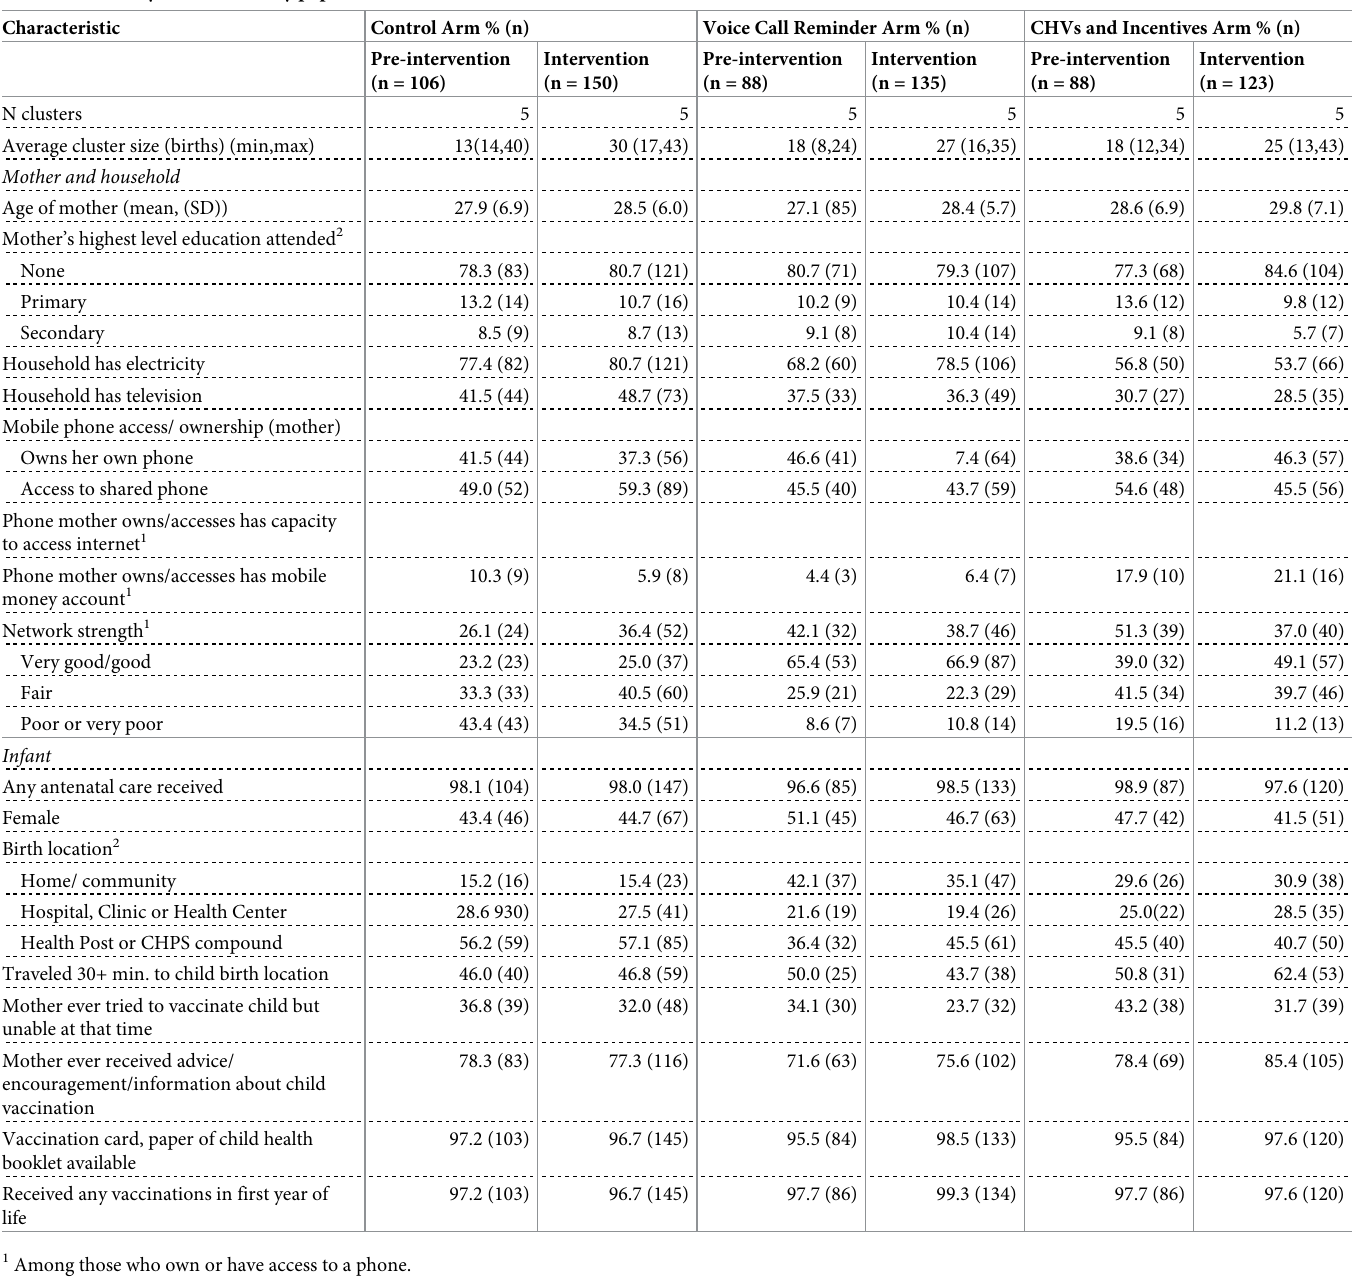
Table 1. Summary of GEVaP study